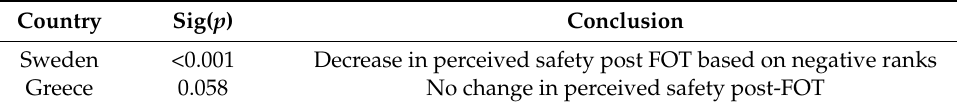
Figure 3. Traffic Information: perception of safety pre- and post-FOT. Table 4. Traffic Information: Wilcoxon test for differences in pre-/post-FOT responses.